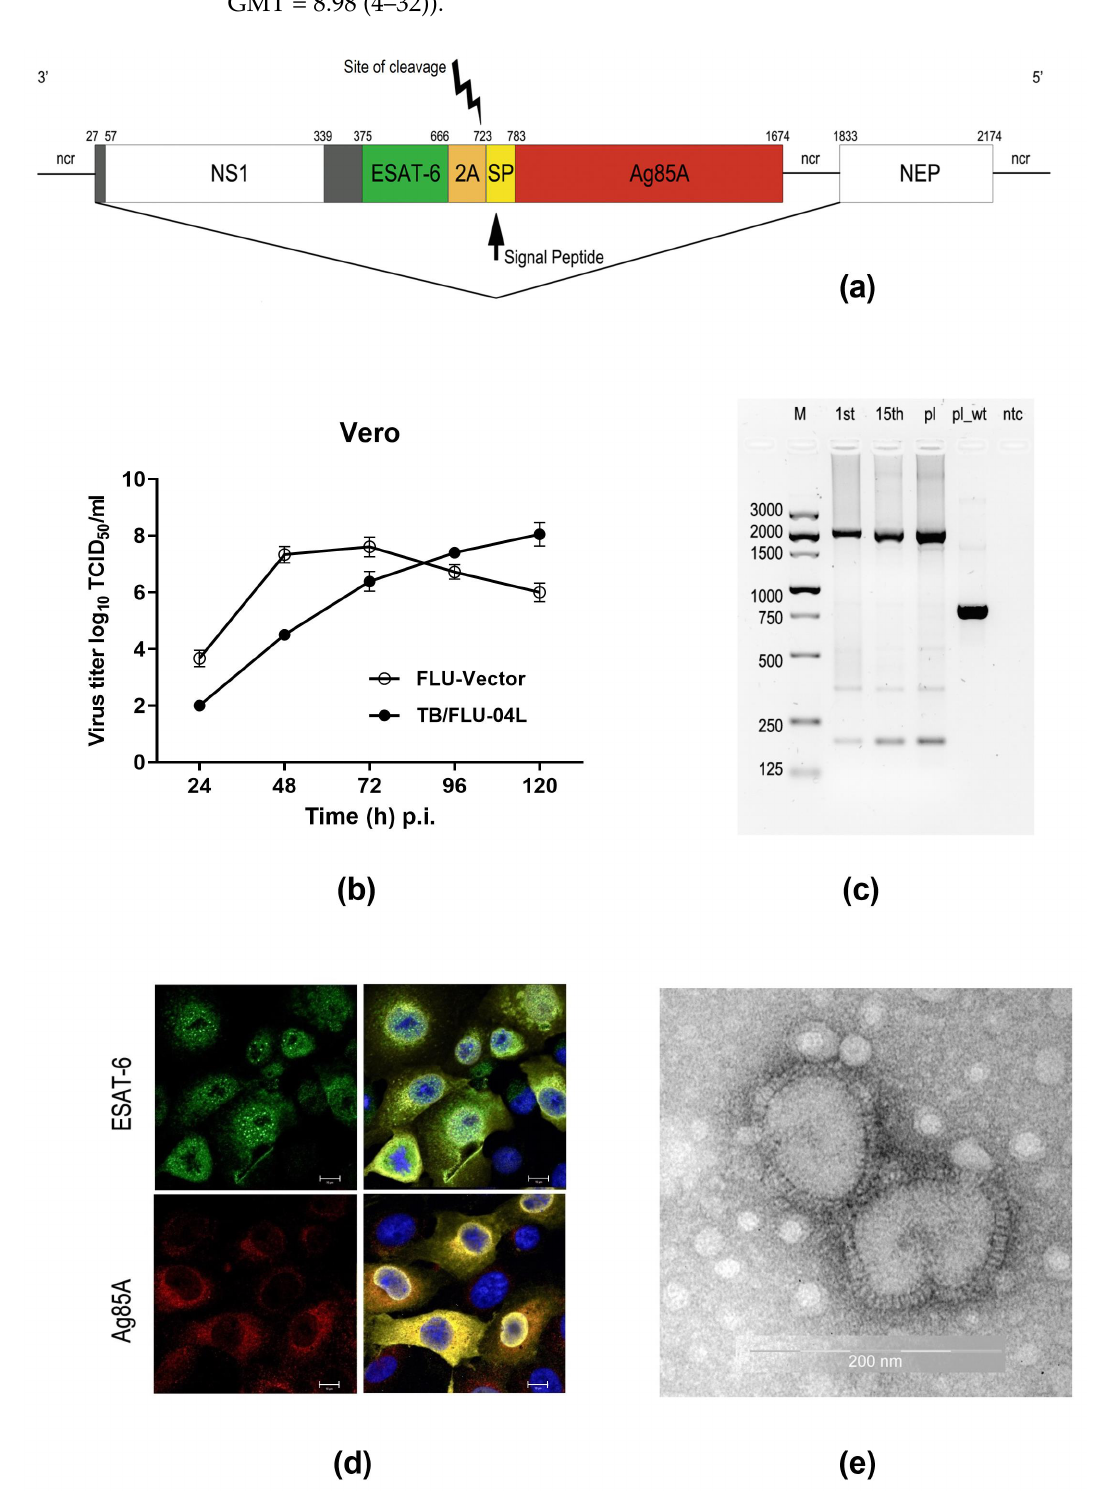
Figure 1. Construction and molecular characterization of the vaccine strain. ( a ) Schematic representa- tion of the recombinant NS gene segment expressing antigens ESAT-6 and Ag85A of M. tuberculosis . The gray box (27–57) represents 12 aa that are shared between the NS1 and NEP proteins; the gray box (339–375) represents nucleotides encoding a random 12aa segment, fused to nucleotides encoding the ESAT-6 (green box) antigen followed by an autoproteolytic 2A cleavage site (orange box). The